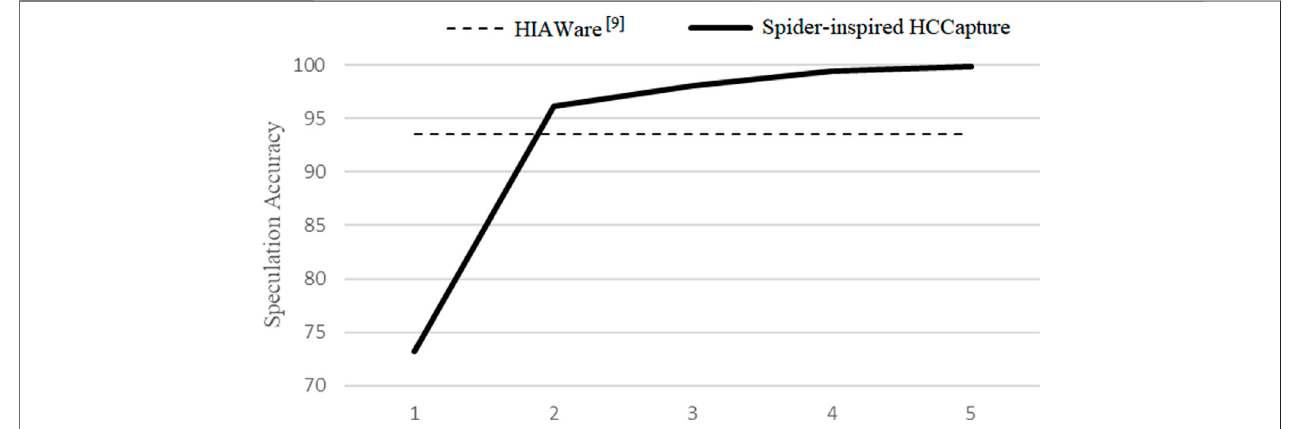
FIGURE 9 | Accuracy: the probability of hitting the correct result, while guesses n times in the sitting posture.